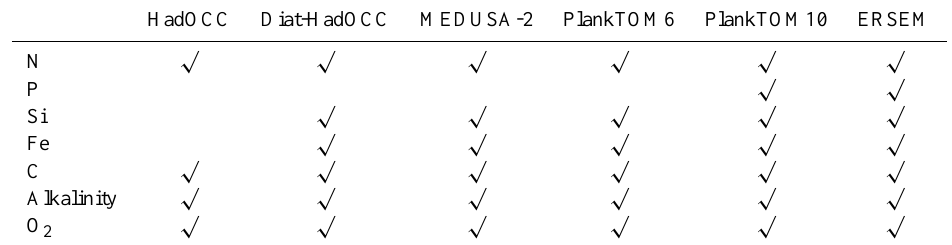
Table 1. Biogeochemical cycles represented in each candidate model.